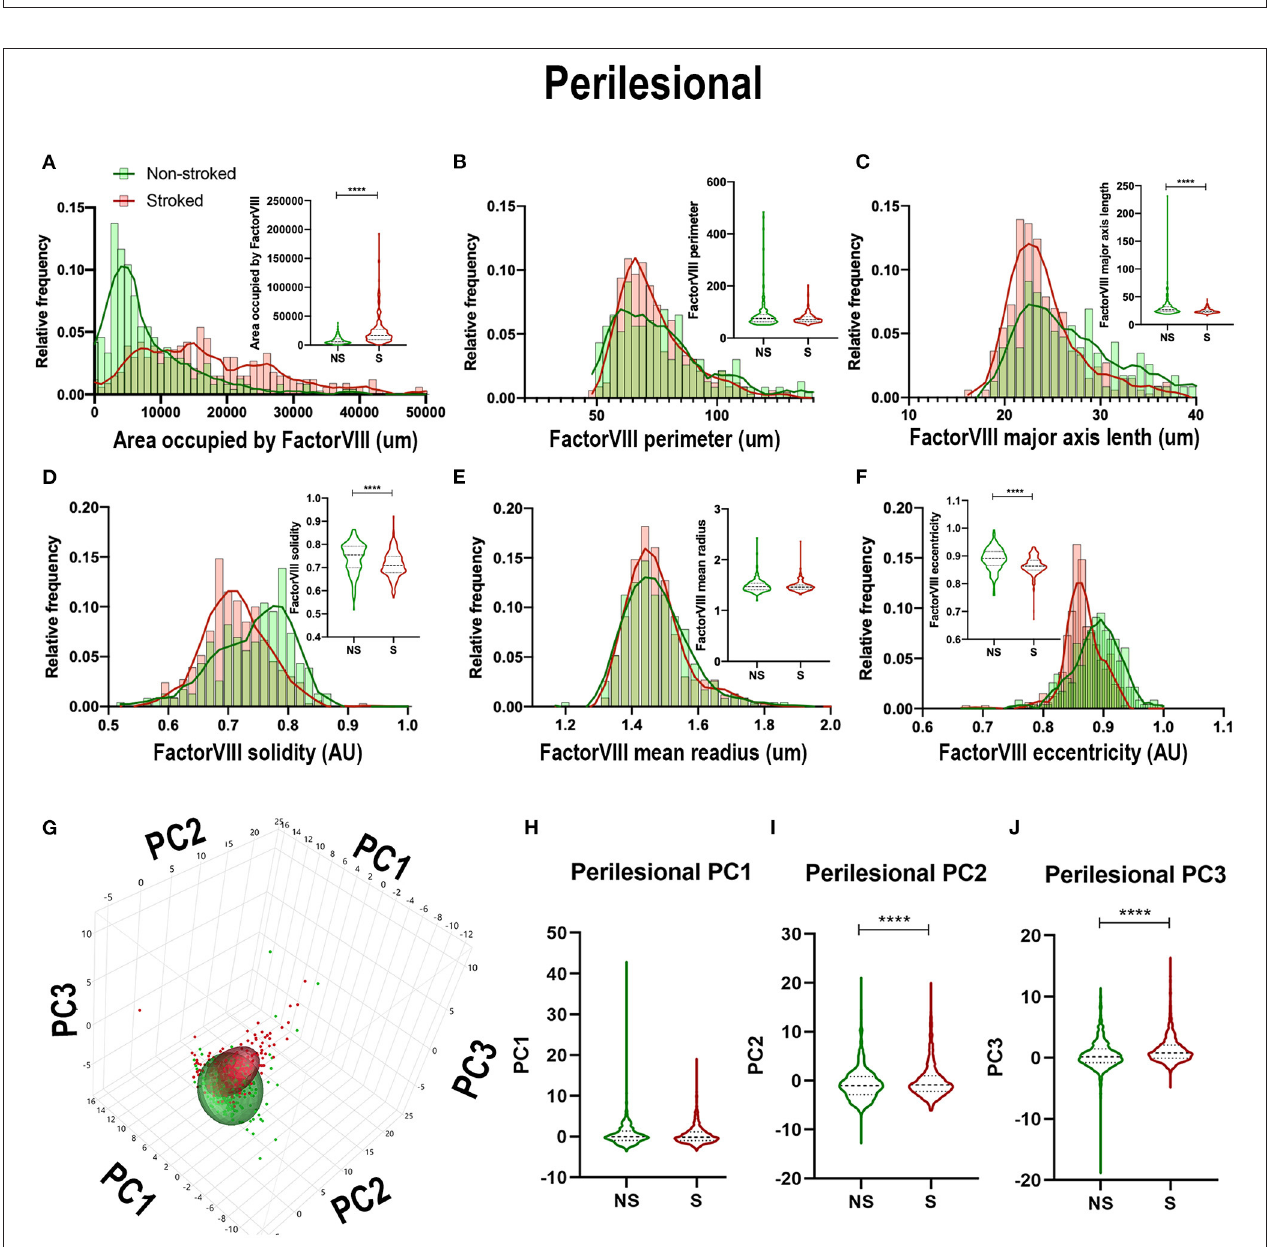
FIGURE 9 | Stroke resulted in a decrease in size and solidity of FactorVIII + areas in perilesional tissue. Significant ( p < 0.0001) increase in NeuN + area occupied (A) , and decreases in major axis length (C) , solidity (D) , and eccentricity (F) were observed in S ( n = 334 ROIs) animals compared to NS ( n = 240 ROIs) animals. No significant differences were seen in perimeter (B) and mean radius (E) . PCA (G) analysis showed no difference in PC1 (H) , but a significant ( p < 0.0001) decrease in PC2 (I) and increase in PC3 (J) observed between S and NS animals. **** p < 0.0001.